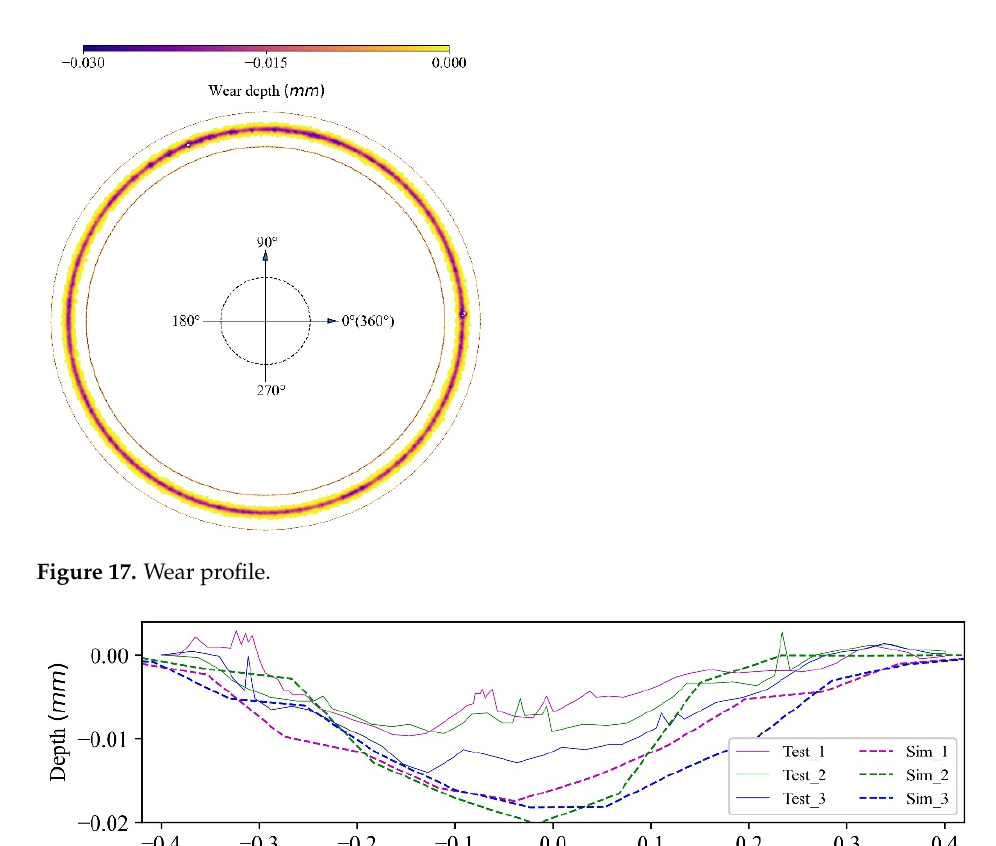
Figure 18. Wear contour comparison.